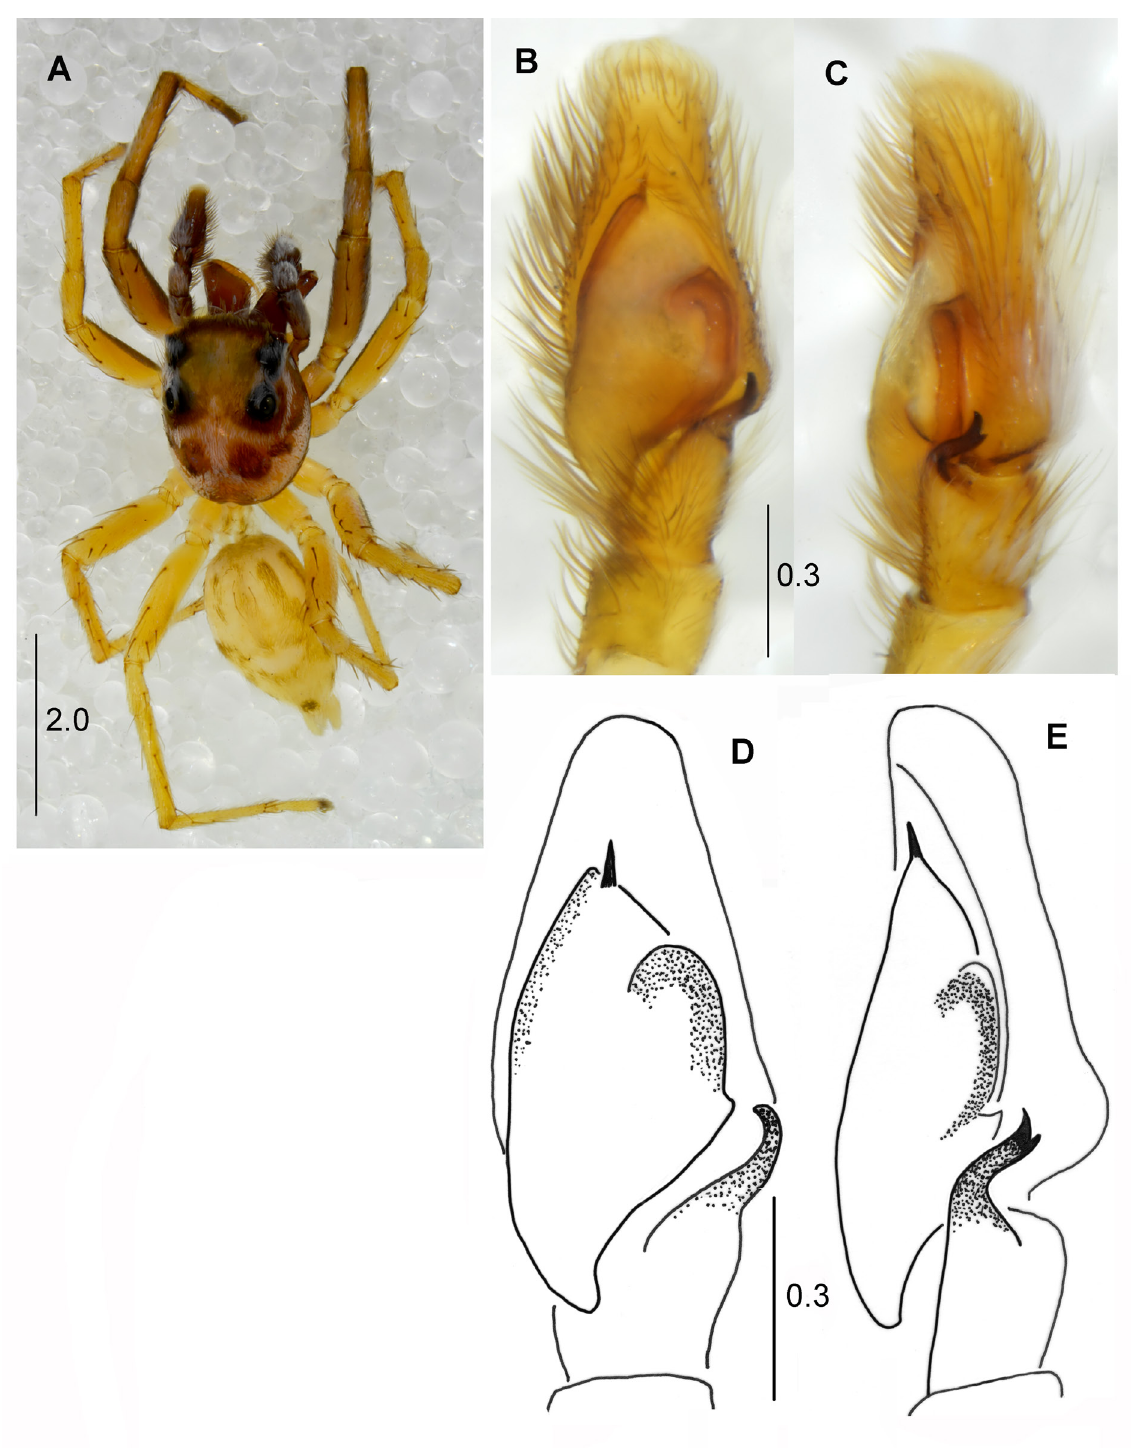
Fig. 43. Phintella brevis sp. nov., paratype, ♂ (MNHN). A . Habitus of male, dorsal view. B, D . Palpal organ, ventral view. C, E . Palpal organ, lateral